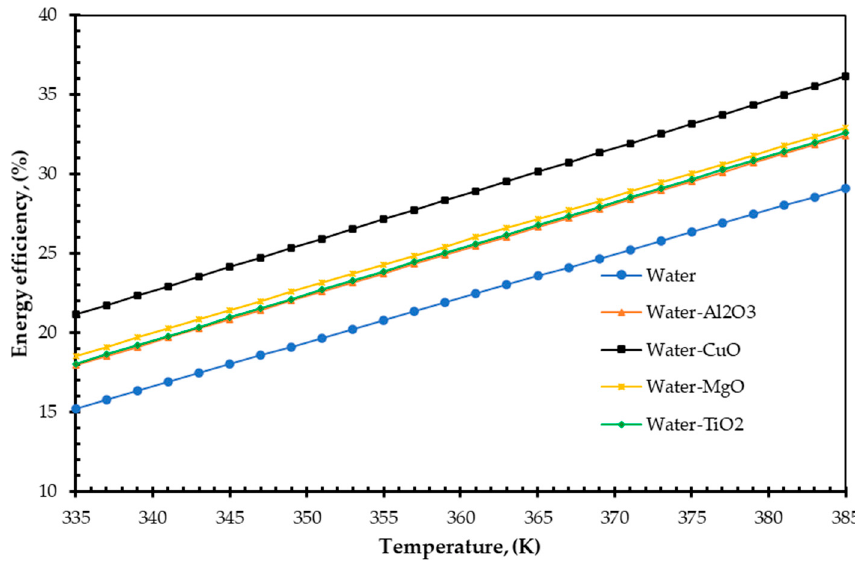
Figure 3. Effect of output temperature on collector energy efficiency.